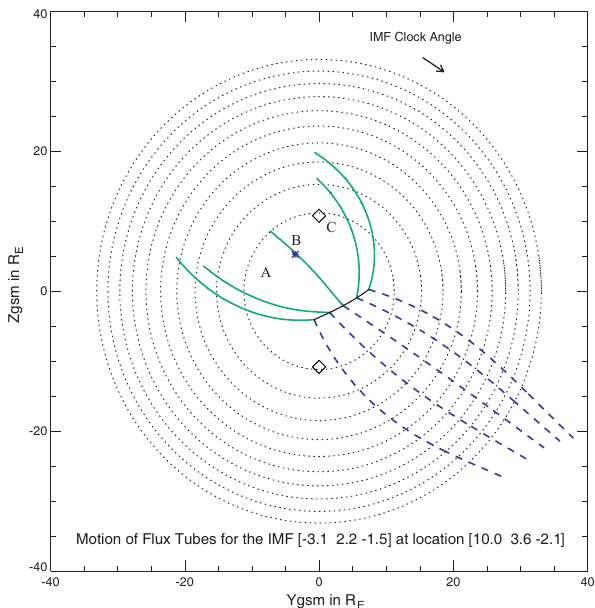
Fig. 3. Motion of reconnected flux tubes for low-latitude reconnec- tion under mean IMF conditions, which is obtained by running the Cooling model. The reconnection conditions are satisfied along a merging line, the projection of which is indicated by the black di- agonal line in the middle of the figure. The solid lines indicate the trajectories of tubes which connect to the northern cusp, and the dashed lines indicate those which connect to the southern cusp. The position of Cluster is represented by the blue star